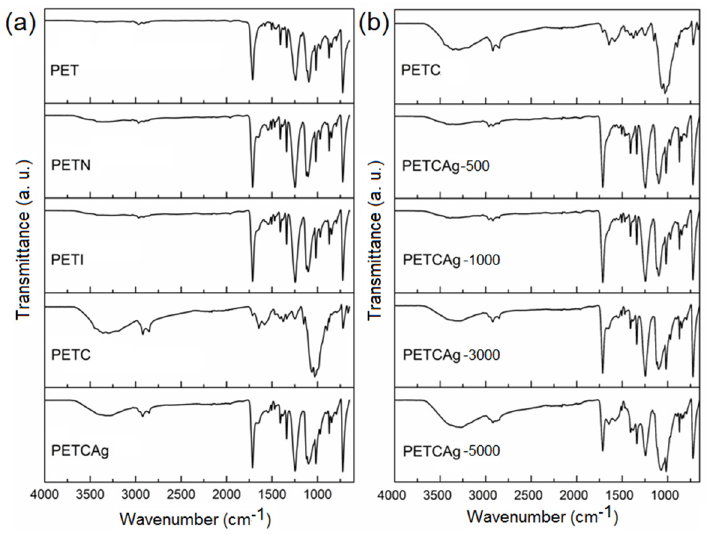
Figure 4. ( a ) FTIR-ATR spectra of PET films in the chitosan chain grafting process; ( b ) FTIR-ATR spectra of the PETC films loaded with silver nanoparticles in different silver nitrate concentrations.